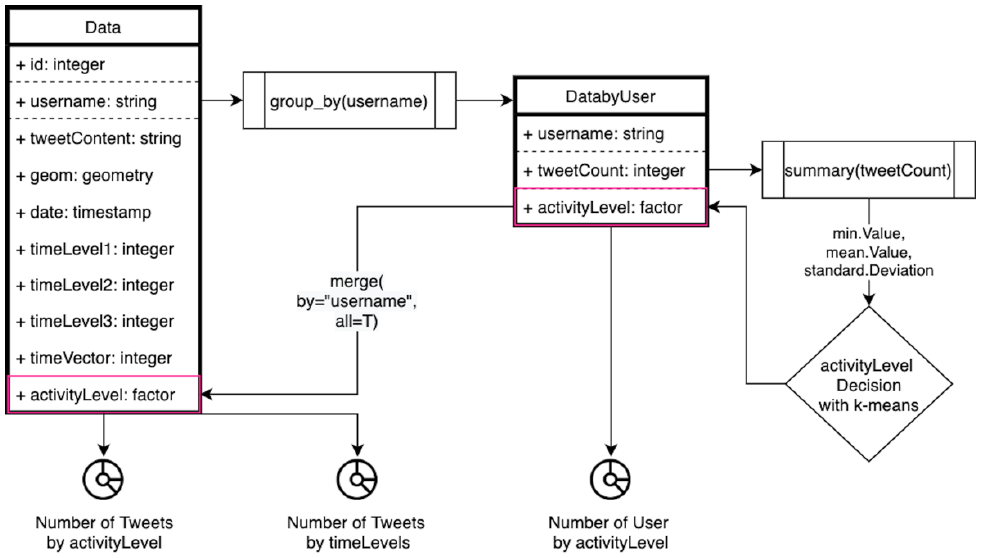
Figure 3. Data investigation methodology flow.